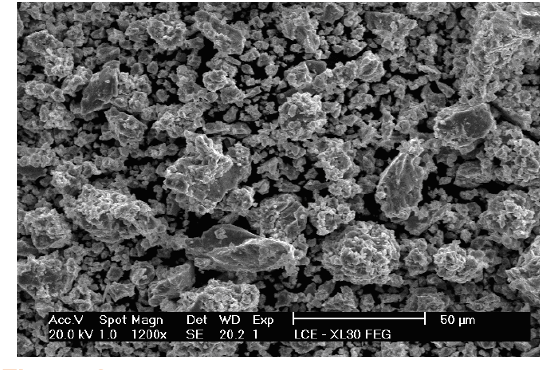
Figure 3. SEM image of the Mg